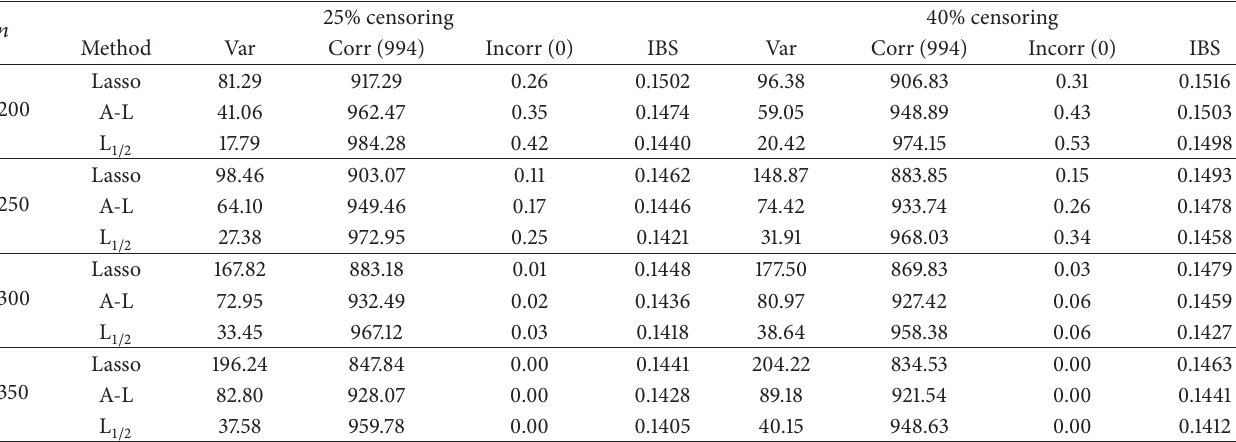
Table 1: The simulation results based on the high dimensional simulated dataset by the three methods over 100 replications. The columns include the average number of the selected variable (Var), the average number of the correct zeros (Corr), the average number of the incorrect zeros (Incorr), and the integrated Brier score (IBS). (Lasso: the Lasso method, A-L: the adaptive Lasso method, and L 1/2 : the adaptive L 1/2 shooting regularization